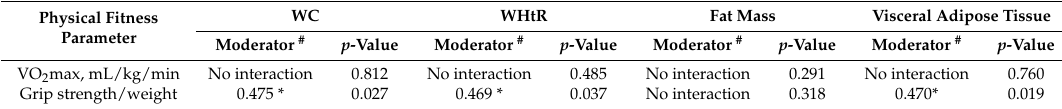
Table 3. Regression slope estimates for the relationship between anthropometrics and body composition and the controlled attenuation parameter with grip strength as moderator based on Johnson-Neyman results.